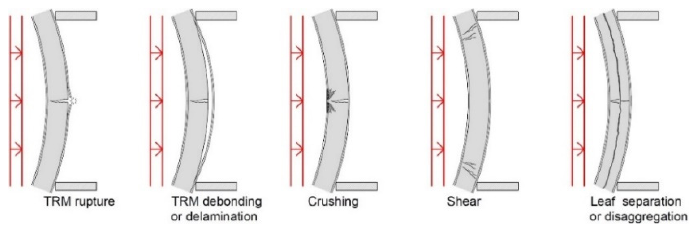
Figure 5. Out-of-plane loading: typical failure mode of TRM-strengthened masonry elements.